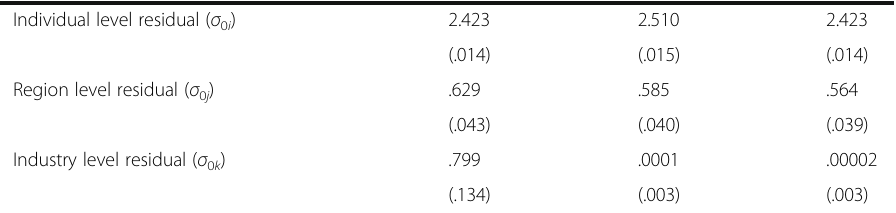
Table 3 Cross-classified multilevel models for individual monthly income (Log), CFPS2010